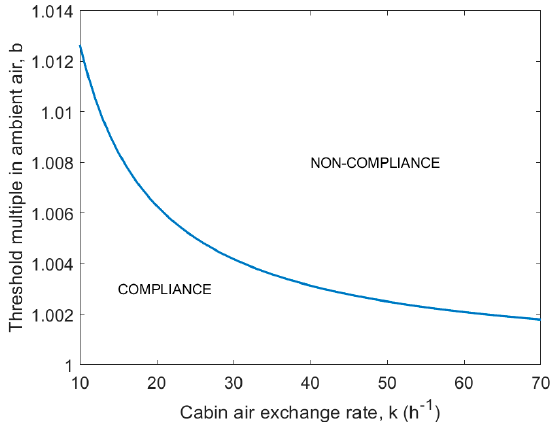
Figure 3. H&S standard compliance in cabin air with respect to substances emitted exclusively outside cabin, such as NO, NO 2 , and